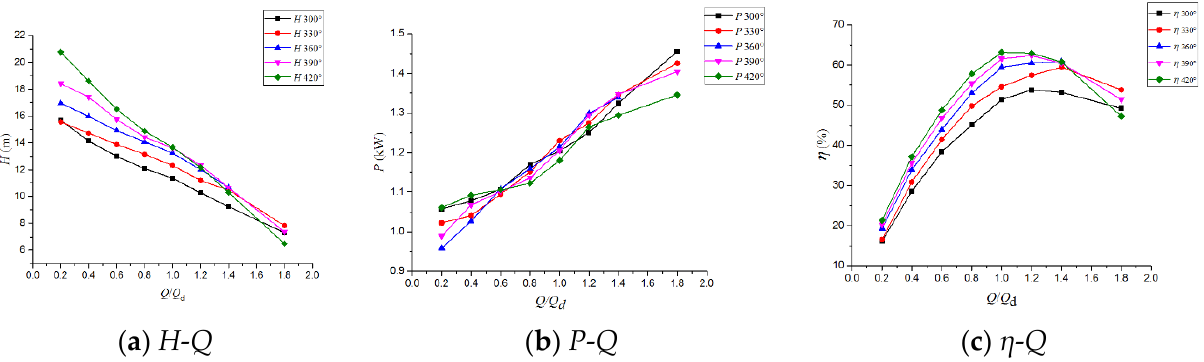
Figure 7. External characteristics of single blade centrifugal pump with different wrap angles. The turbulent dissipation rate cloud diagram of single blade centrifugal pump with different blade wrap angles at designed flow conditions are shown in Figure 8. It can be seen from the figure that the turbulence dissipation rate of single blade centrifugal pumps with blade wrap angle less than 360° is significantly higher. For other impellers, the dissipation rate changes no longer significantly after the wrap angle reaches 360°.